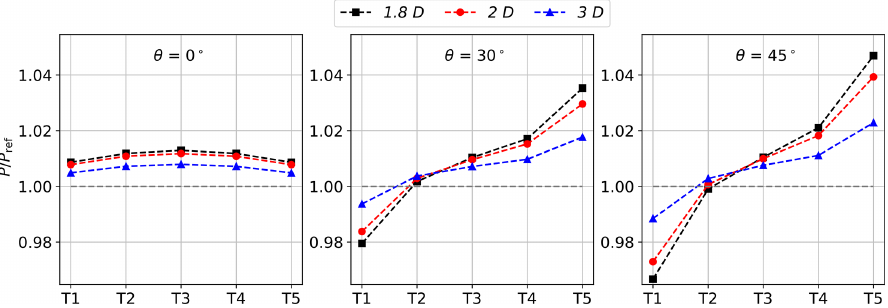
Figure 4. Power output of the five turbines normalised by that of an isolated turbine (placed at T3) for U ∞ = 8ms − 1 and a number of θ values and turbine inter-spacings.